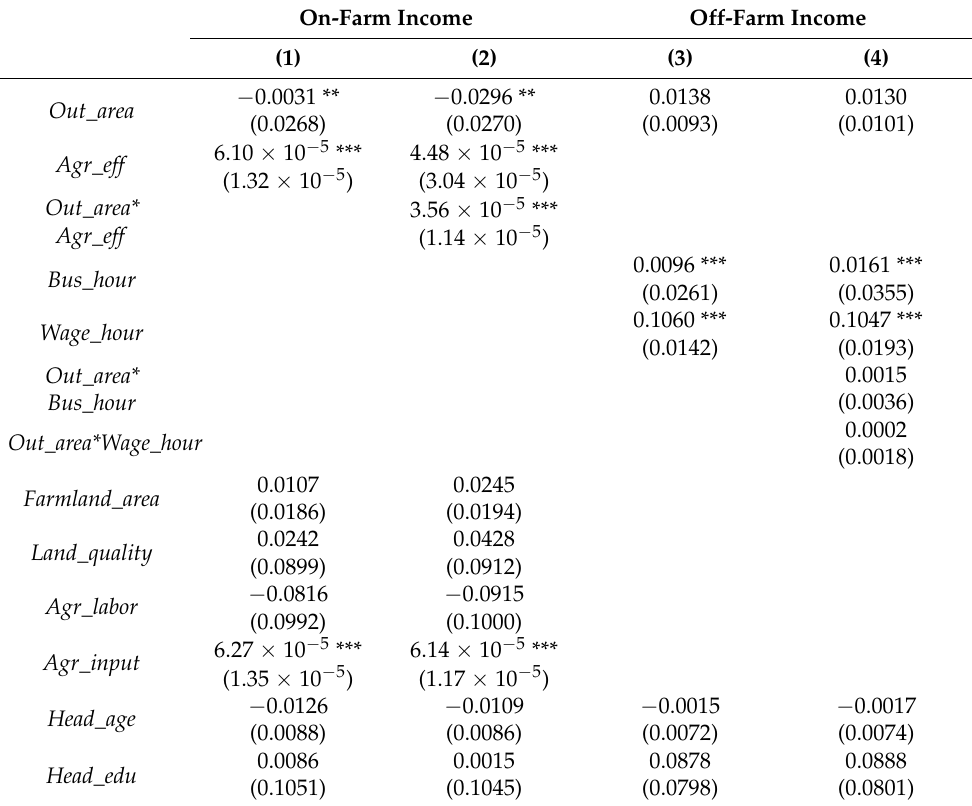
Table 7. The effects of the rented out area and agricultural productivity on household on-farm income for lessor